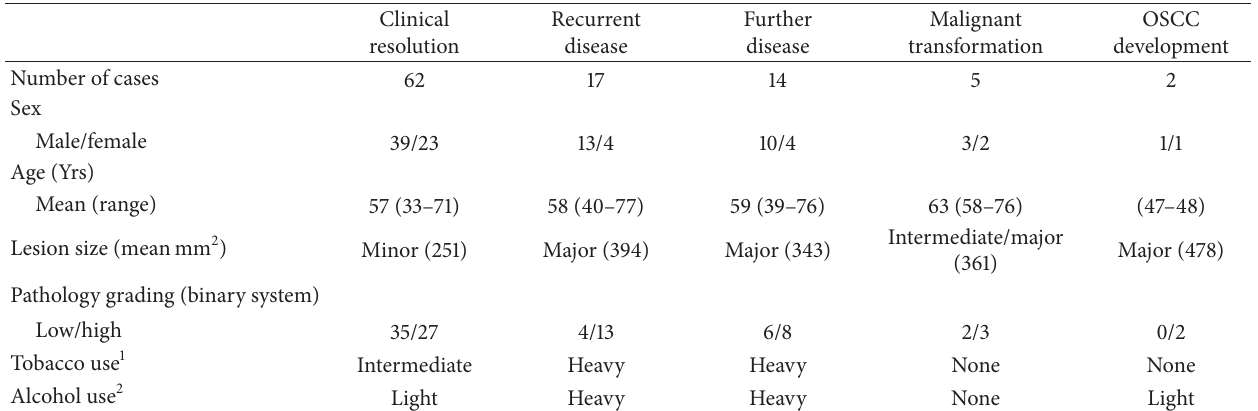
Table 2: Risk profile and clinical outcome.